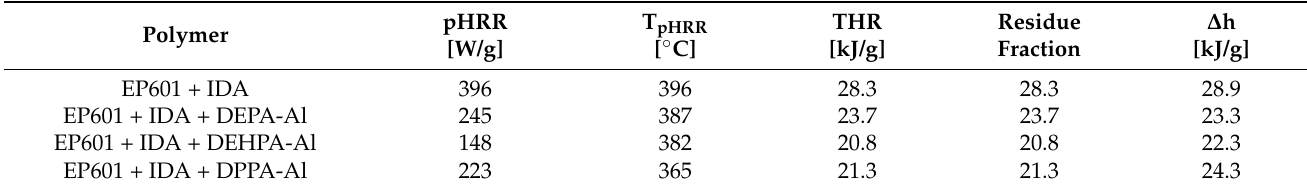
Table 6. Results for PCFC tests.